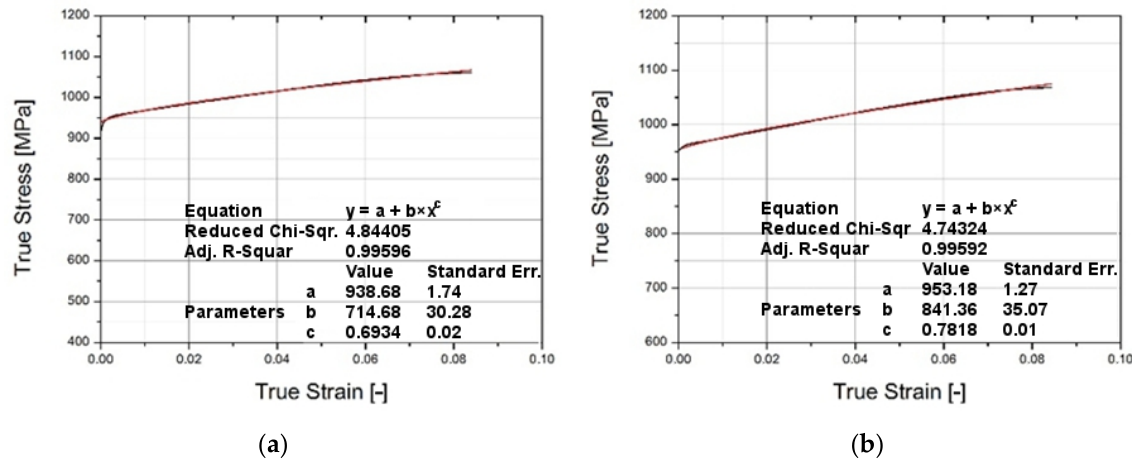
Figure 6. Stress–strain characteristic for specimen’s gauge length: 18 mm ( a ) and 30 mm ( b ) with power function approximation.